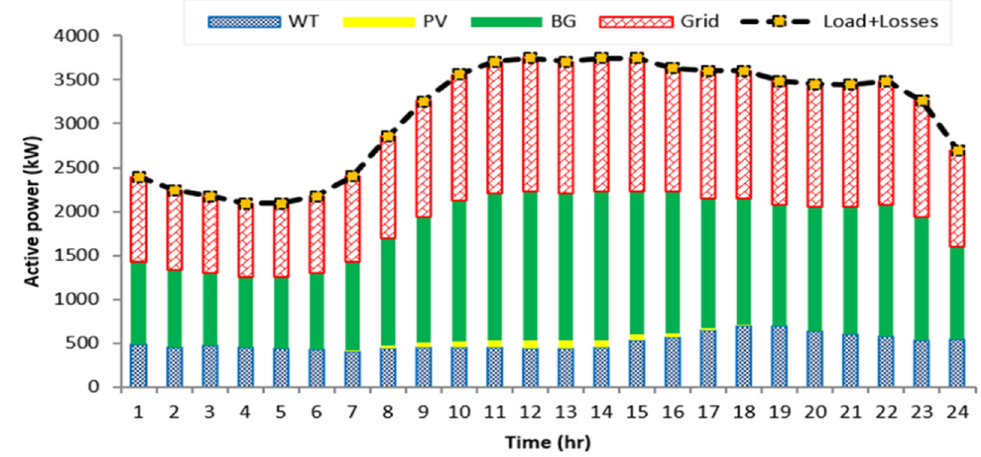
Figure 12. Results of the optimal operation of the first MG.